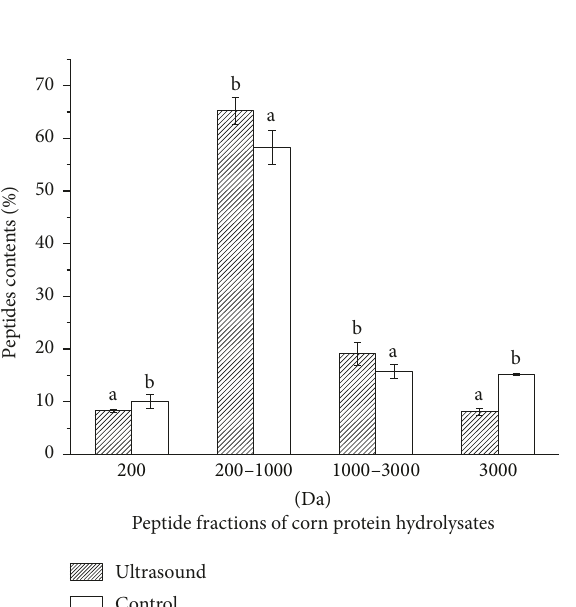
Figure 1: Molecular weights distribution of corn protein hydrolysates. a , b Values which are significantly different at 𝑃 < 0.05